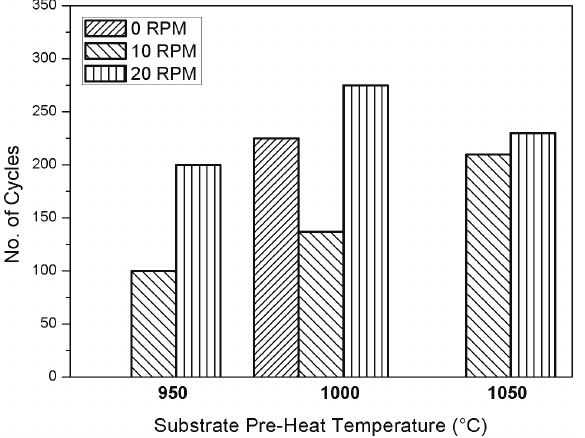
Figure 9. Thermal cycling lives of the various 7YSZ coat- ings tested at 1100°C in